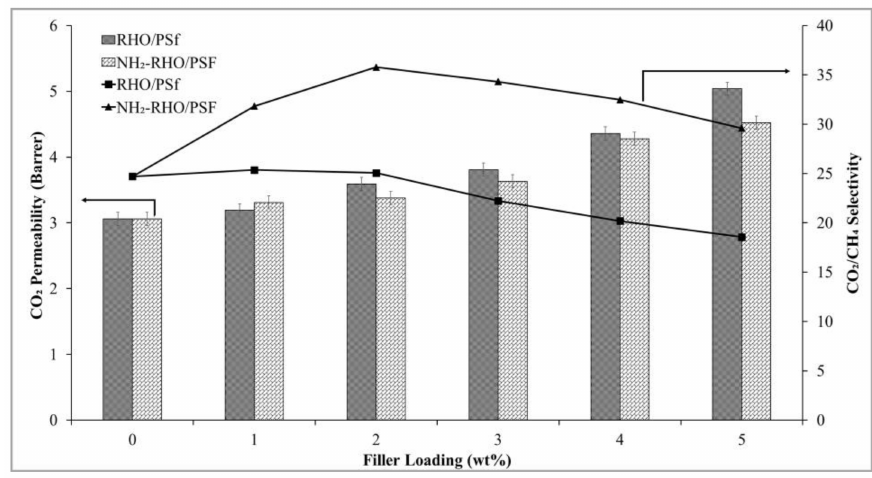
Figure 12. Gas permeation and separation performance of pristine PSf membrane and